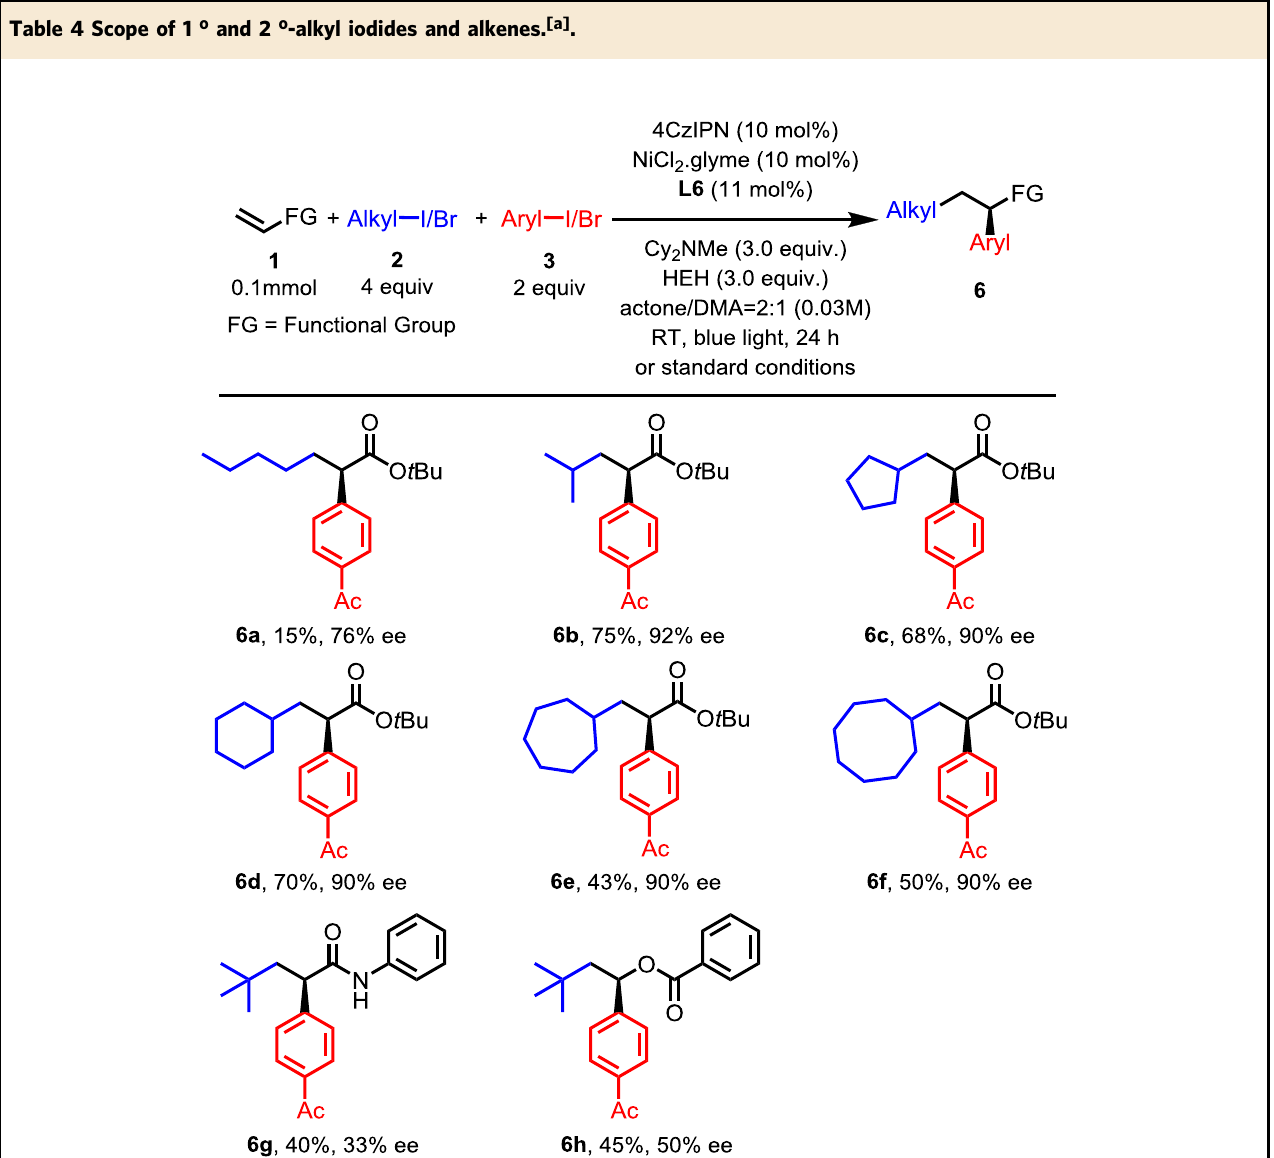
Table 4 Scope of 1 o and 2 o -alkyl iodides and alkenes. [a]